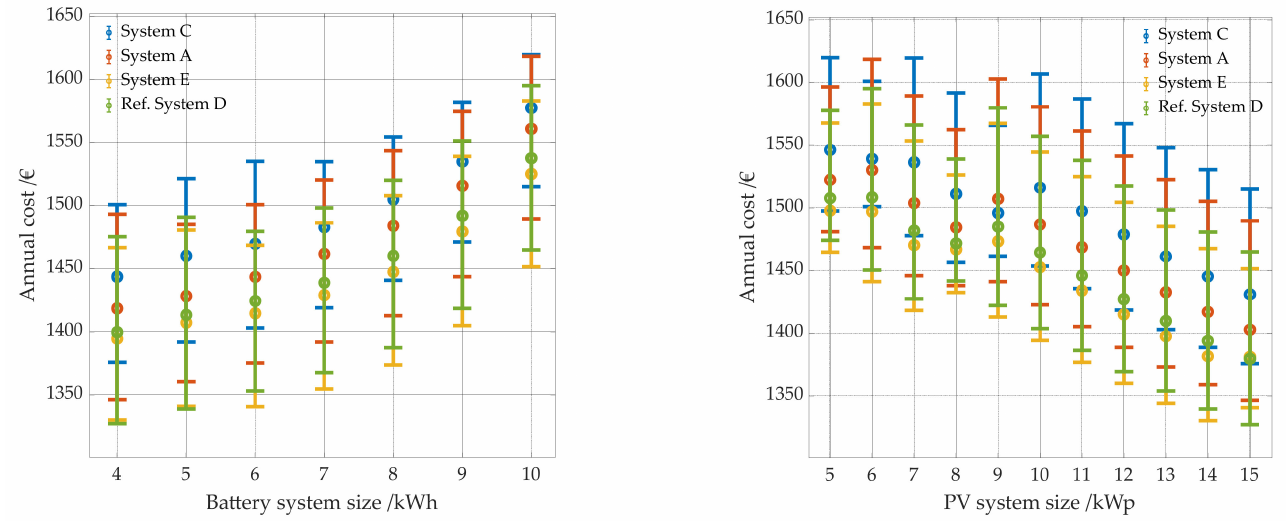
Figure 15. Electricity costs per year as a function of the battery system size ( left panel) and the PV system size ( right panel). Simulations were performed with the efficiency curves of systems C, A, E and D with an average pathway efficiency of 83.70, 89.35, 94.32 and 92.50% and for the AC2BAT path and of 83.70, 89.35, 94.32 and 92.50% for the path